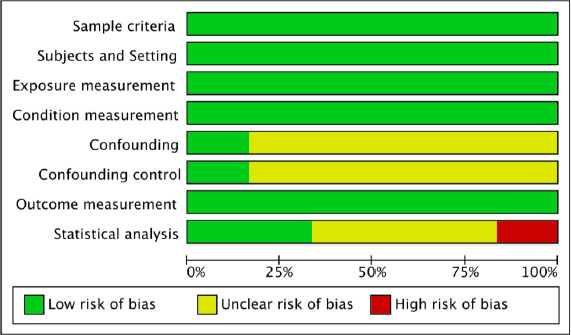
Risk of bias graph: